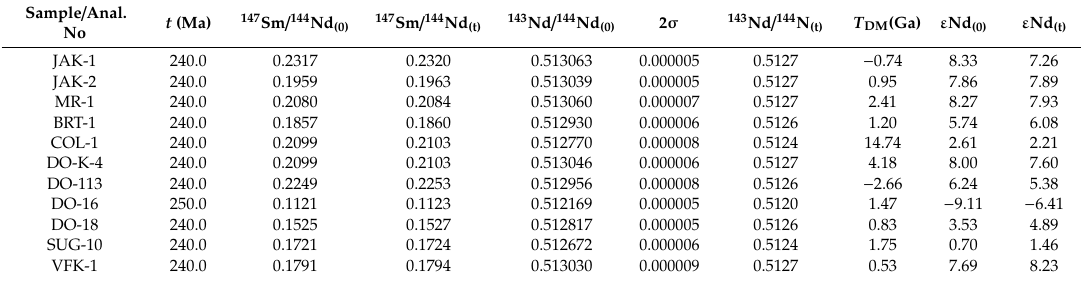
Table 2. Sm–Nd isotopic data of studied